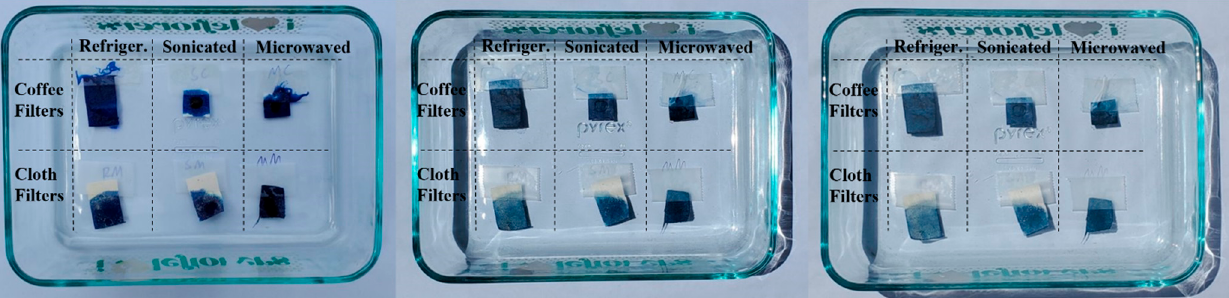
Figure 7. Color degradation results from left to right: after 0, 10, and 20 h. Organized into a table by substrate material (vertical axis) and treatment types (horizontal axis).